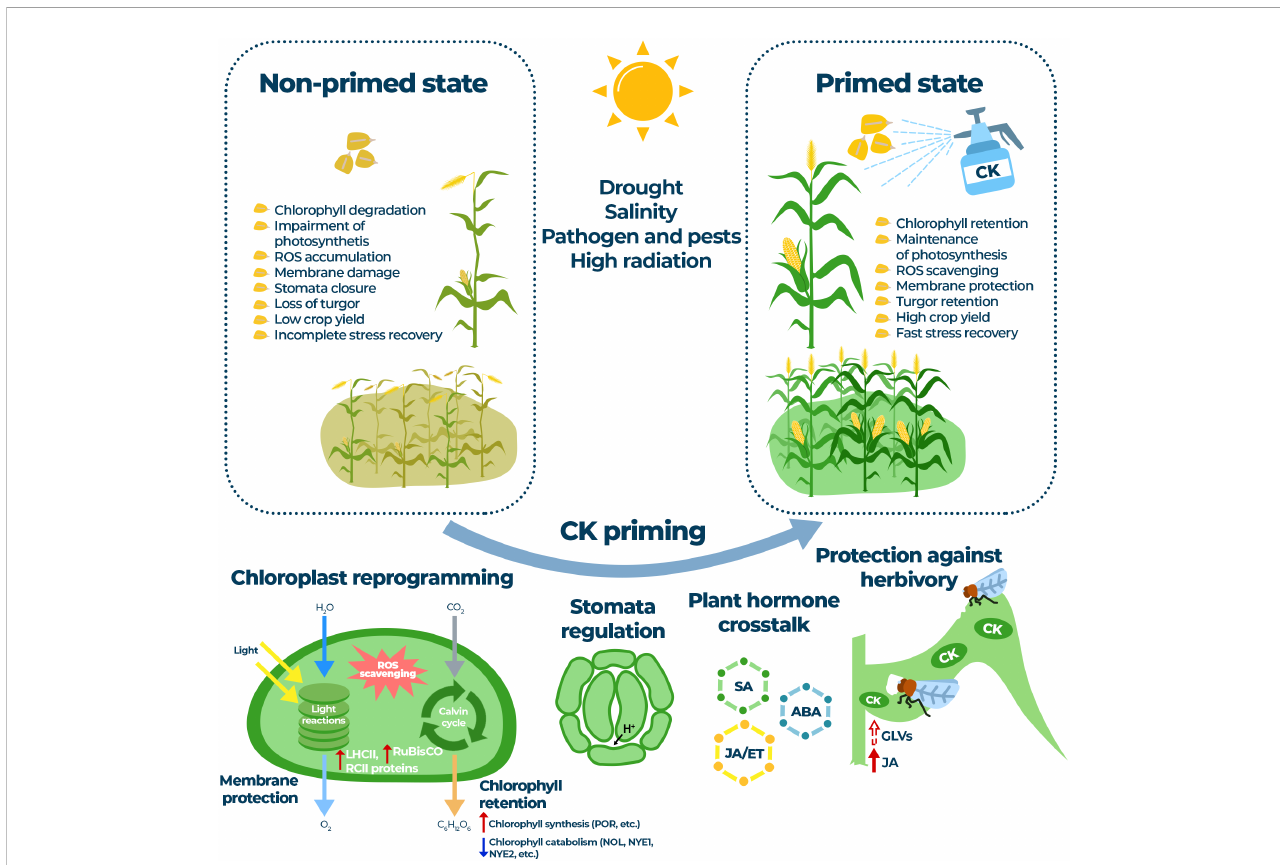
FIGURE 1 A simpli fi ed model showing the bene fi cial effects of cytokinin priming on photosynthesis and plant regulatory processes under stress conditions. Cytokinins can protect the light and dark reactions of photosynthesis by processes such as chlorophyll retention (upregulation of chlorophyll biosynthesis and downregulation of chlorophyll catabolism; cytokinin upregulated genes coding for POR , Protochlorophyllide oxidoreductase and downregulated genes coding for NOL , Chlorophyll b reductase; NYE1 , Non-yellowing 1, and NYE2 , Non-yellowing 2, are shown). Other cytokinin regulated processes include upregulation of LHCII and RCII components, upregulation of RuBisCO activity and activation of ROS scavenging system leading to membrane protection. Another important mechanism of action of cytokinins during stress and recovery is the desirable crosstalk of cytokinins with traditional plant stress hormones, potentially including volatile substances (GLVs). During herbivory, so-called “ green islands ” with elevated levels of CKs are formed; crosstalk mediated by volatile compounds and other phytohormones can initiate defense priming. Thus, the application of